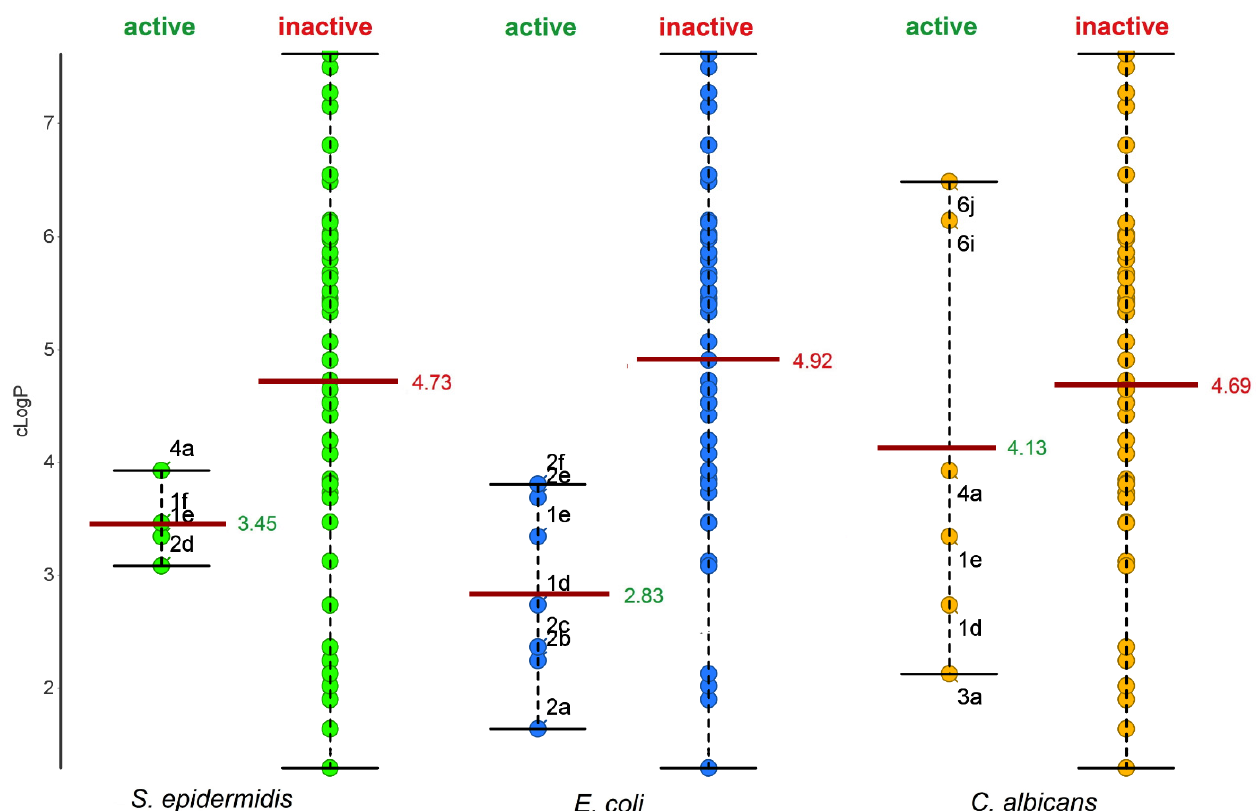
Figure 2. The cLogP values split by the active or inactive status against S. epidermidis , E. coli , and C. albicans . The horizontal lines represent the average values for each data column.